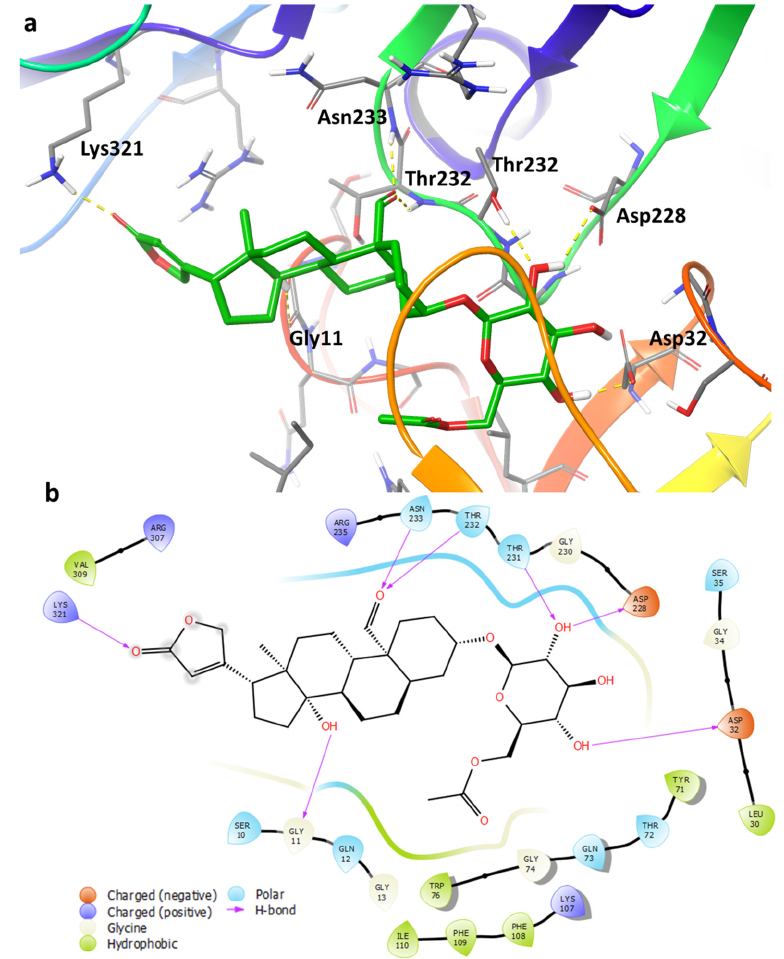
Figure 7. ( a ) Predicted binding pose from induced-fit docking for compound (ligand 1 ), shown in green, bound to BACE1. This binding pose, which is similar to the poses predicted for ligands 2 and 3 , forms several hydrogen-bonds with the surrounding residues shown in yellow dashed lines. Only selected residues are shown for clarity. ( b ) 2D ligand interaction diagram for the binding pose of 1